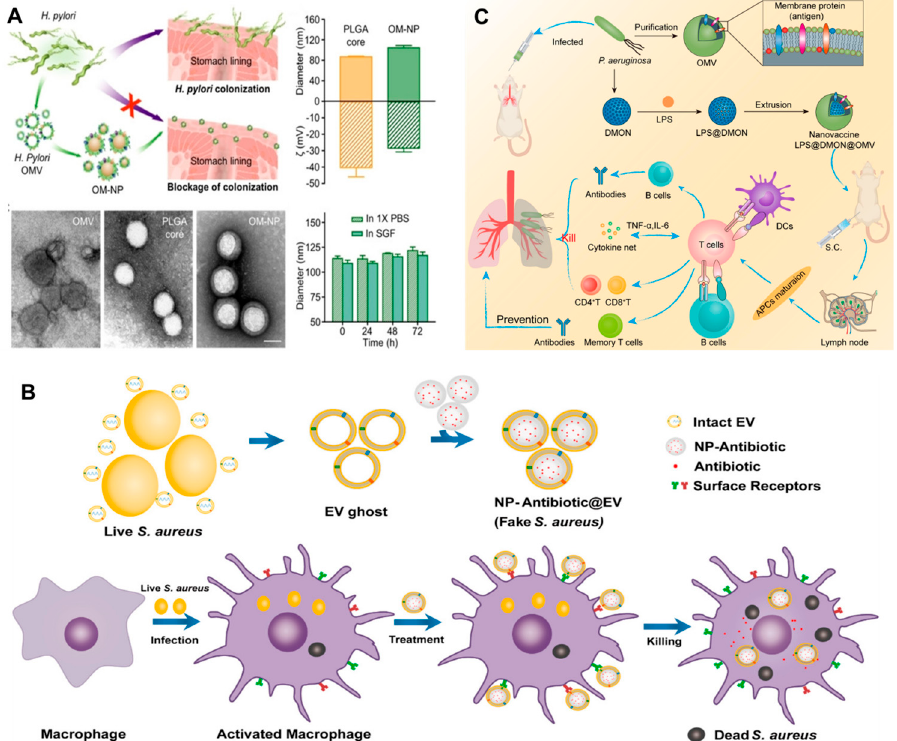
Figure 9. ( A ) Schematic representation of BM-PLGA [BMs coated on polymeric cores made of poly (lactic-co-glycolic acid] mediated inhibition of H. pyroli adhesion on the stomach lining; TEM, hydrodynamic diameter, the zeta potential of BM-PLGA and its stability in 1 X PBS and simulated gastric fluid [reproduced with the permission from Zhang et al. [136], copyright 2019 Wiley]. ( B ) Schematic representation of the preparation of PLGA@BMs, by fusing the derived membrane vesicle of the secreted by S. aureus over the surface of PLGA nanoparticles, exposure of a macrophage to S. aureus leads to phagocytosis, consequent antigen presentation, and re-exposure of the phagocyte to the same pathogen type leads to rapid identification and clearance [reproduced with permission from, Gao , et al. [138], copyright 2018 American Chemical Society]. ( C ) Schematic representation of the antipseudomonal immune regulation of LPS@DMON@OMVs encapsulated by BMVs [reproduced with permission from Wu et al. [139], copyright 2022 Elsevier].